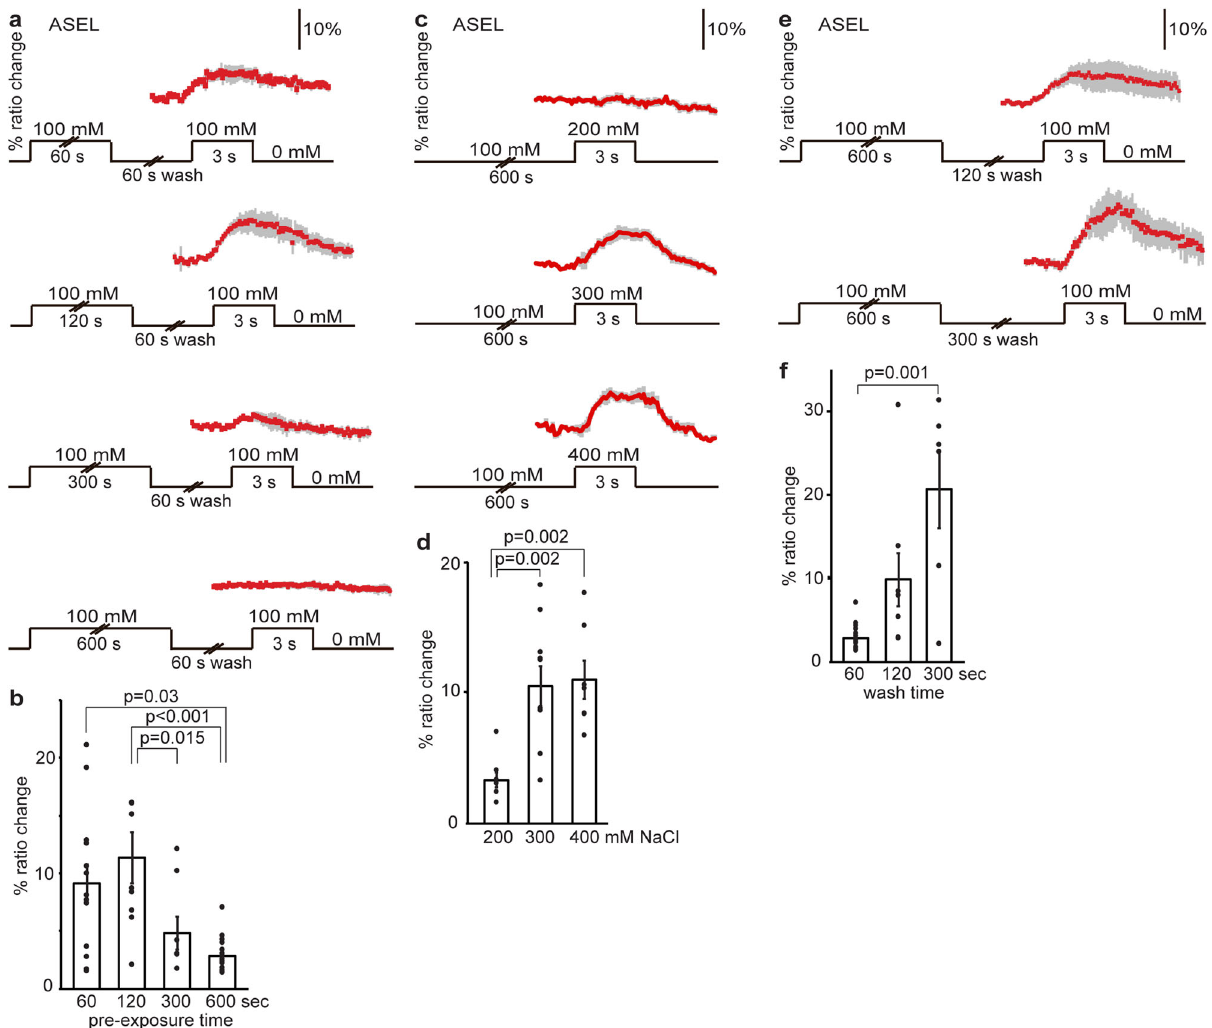
Fig. 3 Pre-exposure to NaCl desensitizes ASEL. a , b Animals were pre-exposed to 100 mM NaCl for 60 – 600 s, washed brie fl y (60 s), and exposed to 100 mM NaCl. a Average Ca 2 + transient (±SEM) in ASEL in response to 100 mM NaCl after pre-exposure for 60 s ( n = 14), 120 s ( n = 9), 300 s ( n = 8), or 600 s ( n = 16 animals). b Average maximum ratio changes (±SEM) in ASEL after pre-exposure: responses after 300 and 600 s pre-exposure were signi fi cantly reduced, compared to responses after 60 or 120 s pre-exposure. c , d Animals were pre-exposed to 100 mM NaCl for 10 min, before test exposure to 200, 300, or 400 mM NaCl. c The average Ca 2 + transients (±SEM) and ( d ) the average maximum ratio changes (±SEM) in ASEL. Exposure to 300 ( n = 10 animals) or 400mM ( n = 7) NaCl yielded signi fi cantly stronger Ca 2 + transients than 200 mM ( n = 8). e , f Animals were pre-exposed to 100 mM NaCl for 10 min, washed for 1, 2, or 5 min in a NaCl-free buffer and re-exposed to 100 mM NaCl, where ( e ) shows the average Ca 2 + transients (±SEM) and ( f ) the average maximum ratio changes (±SEM) in ASEL. Five minutes wash with a NaCl-free buffer restored the Ca 2 + response of ASEL to 100 mM NaCl. Wash time: 1 min ( n = 16), 2 min ( n = 8), 5 min ( n = 6 animals). Individual data points have been indicated as dots. Statistically signi fi cant differences have been indicated (non-signi fi cant differences, p > 0.05, have not been indicated). Source data underlying this fi gure are available in Supplementary Data